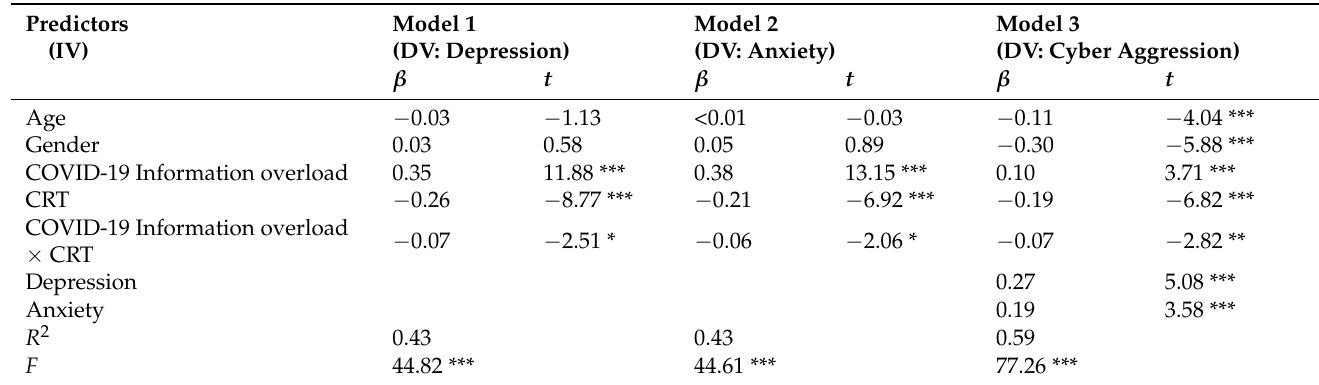
Table 4. Testing the moderated mediation effect of COVID-19 information overload on cyber aggression.